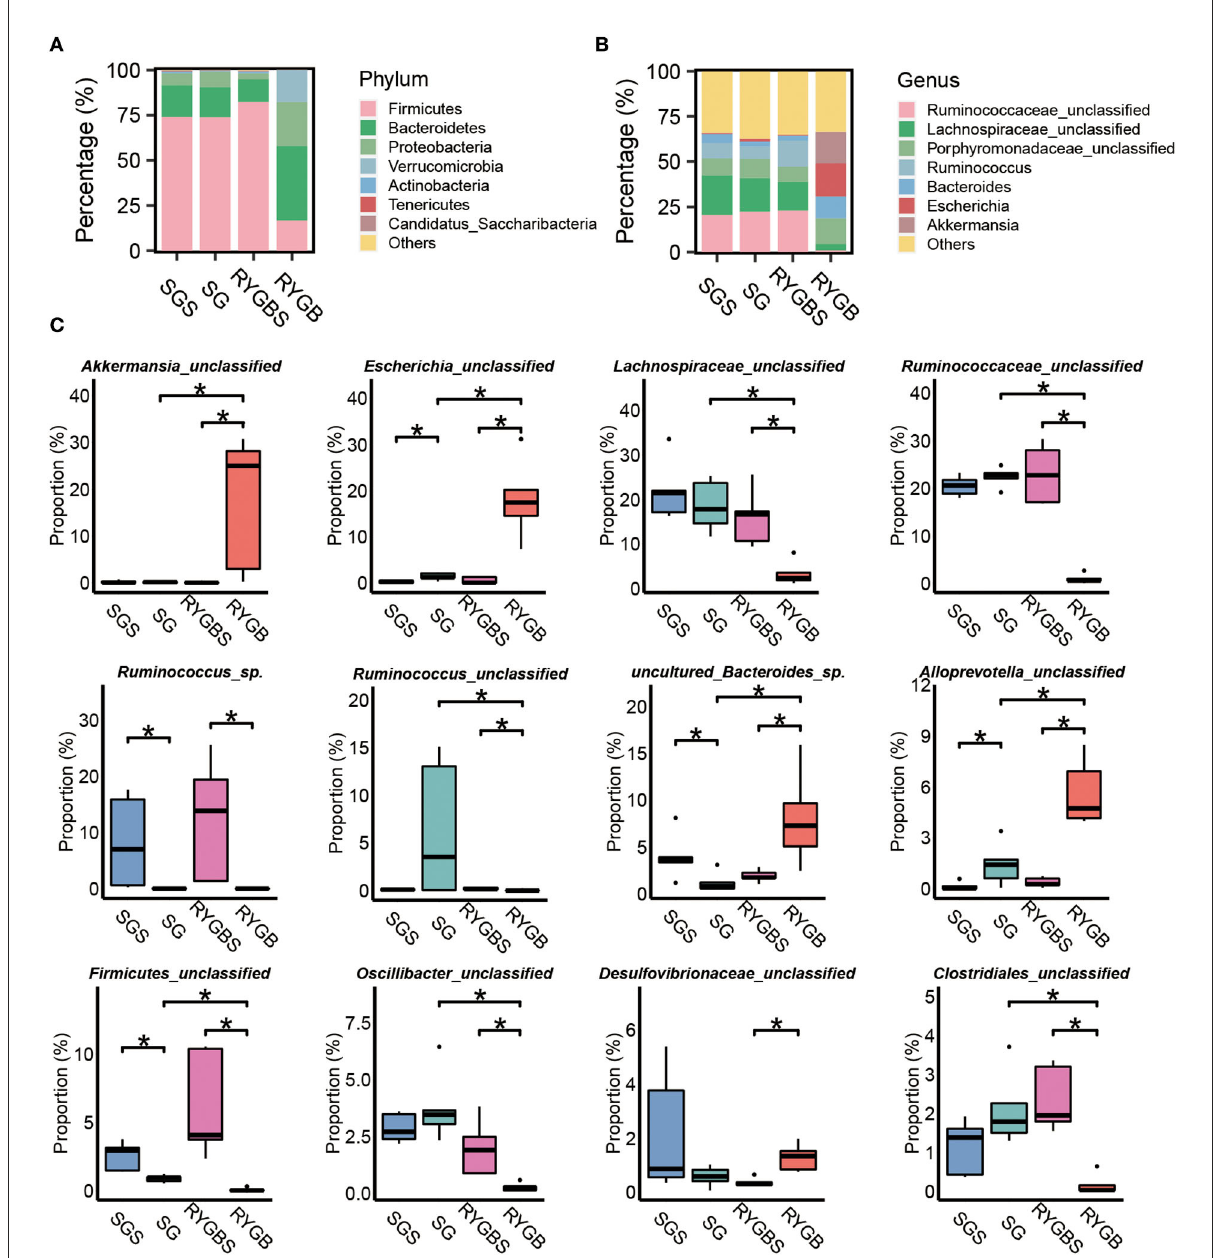
FIGURE2 Identification of specific altered bacteria for SG and RYGB. (A,B) Stacked bar plots depicting the percentage of phylum (left) and genus (right) of intestinal bacteria in the screening results. (C) Significantly changed bacteria at the genus levels in gut microbiota. * P < 0.05, Kruskal–Wallis test with post-hoc Dunn’s